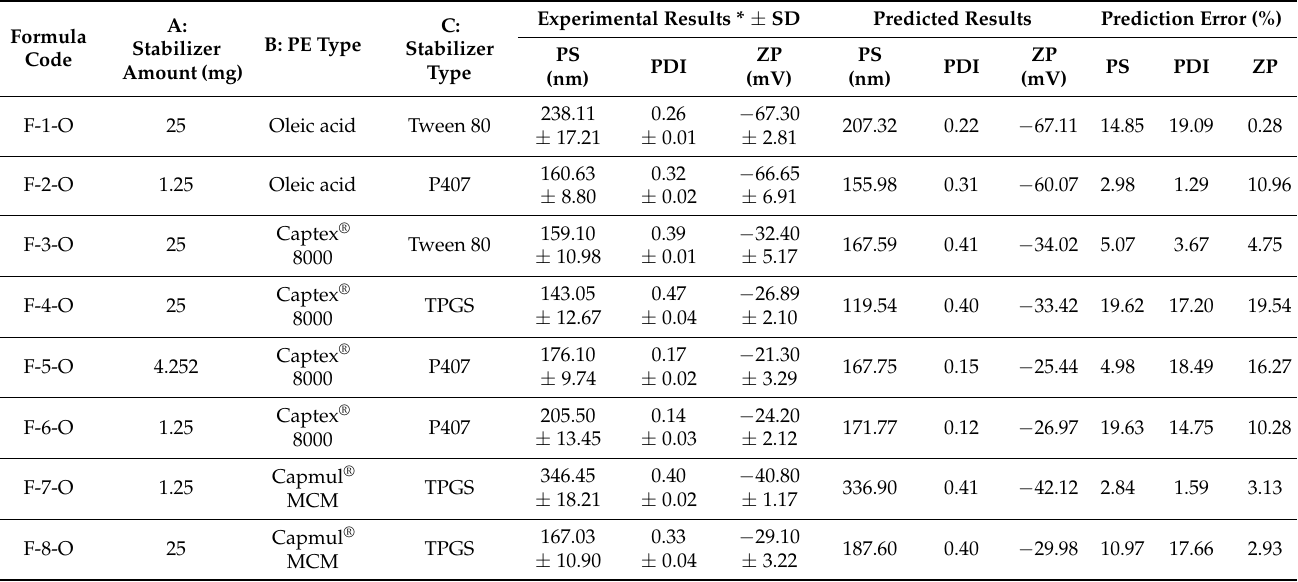
Table 3. Compositions, experimental and predicted data, and prediction error (%) of PS, PDI, and ZP responses of the optimized liquid crystalline